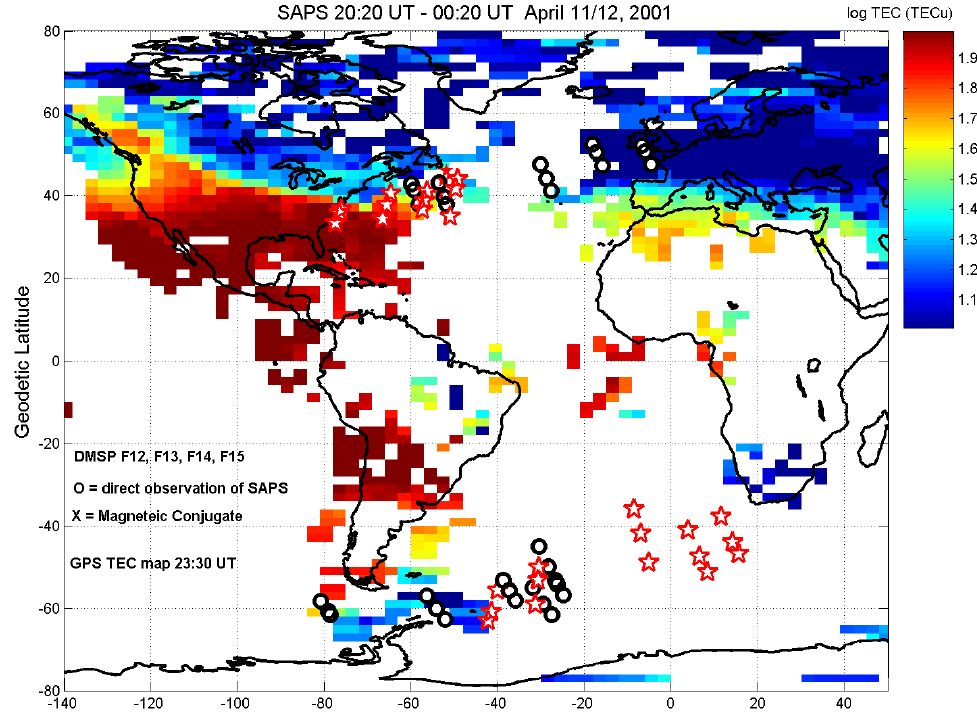
Fig. 6. Direct observations of the position of the SAPS electric field made by the DMSP satellites in both hemispheres over a 4-h interval are denoted by open circles. The magnetic conjugate locations of those points are indicated by red stars. The SAPS electric field is seen to occur in magnetically-conjugate